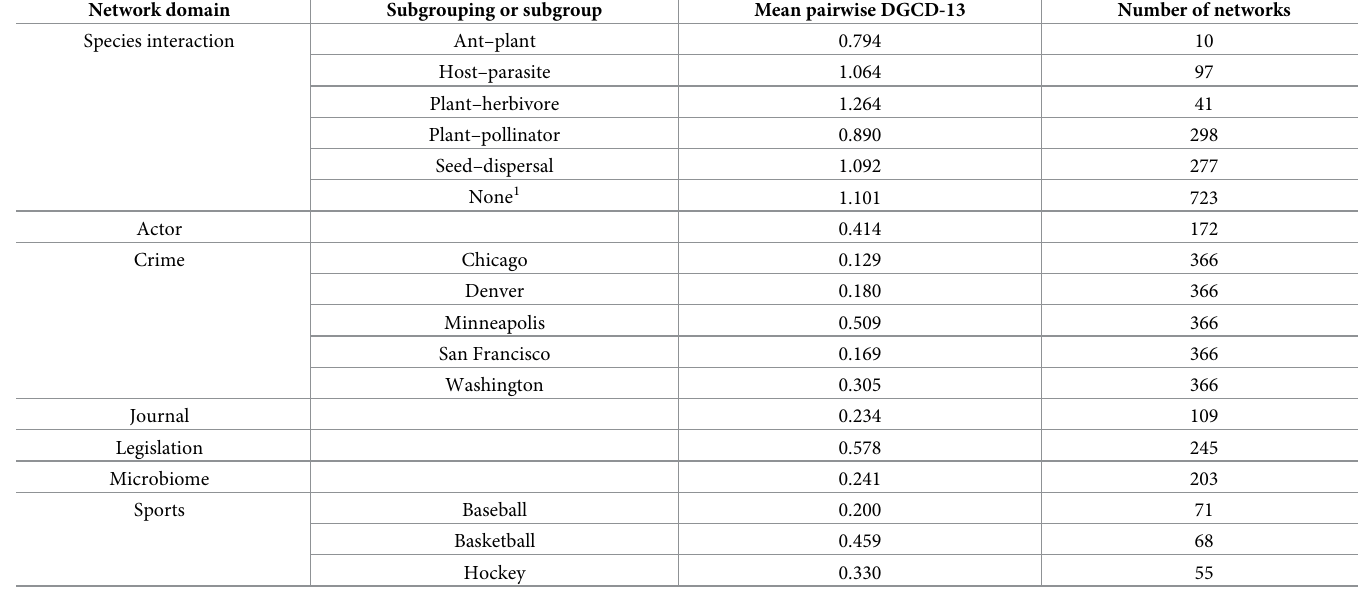
Table 3. Mean pairwise directed graphlet correlation distance-13 (DGCD-13) between bipartite networks from the same domain or subgrouping. Subgrouping refers to a subgroup [i.e., networks classified as the same type of network from the same domain during network construction (e.g., the Chicago networks in the crime network domain)] that formed an obvious cluster within the MDS plot (Fig 4). See Table 2 for a list of network domains and their corresponding subgroups. All species interaction networks were classified into their appropriate subgroup even though they did not form subgroupings.